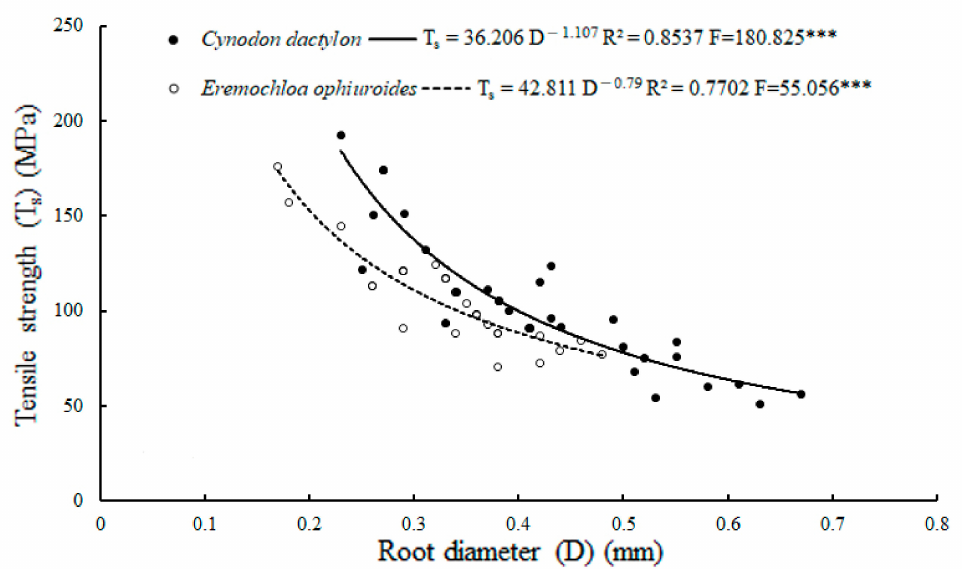
Figure 5. Relationship between root tensile strength and root diameter for C. dactylon and E. ophiuroides . Significance level: *** p < 0.001.